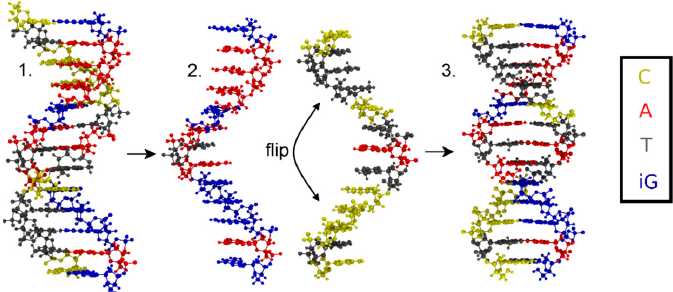
Figure 3. Flowchart depicting the generation of the initial structure with (iso)guanine residues depicted in blue, adenine in red, thymine in grey and cytosine in yellow. 1 . Antiparallel-stranded DNA obtained from 3DNA; 2 . Separated strands, where one stand is flipped by 180°; 3 . Reattached strands forming parallel-stranded DNA.